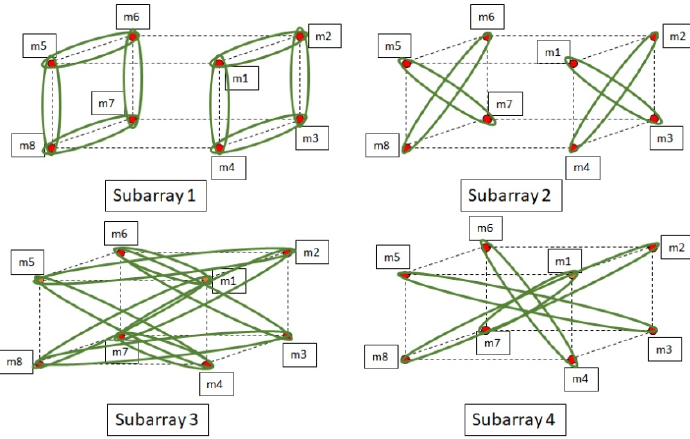
Figure 3. The proposed CuNMA with the related microphone pairs for each subarray.